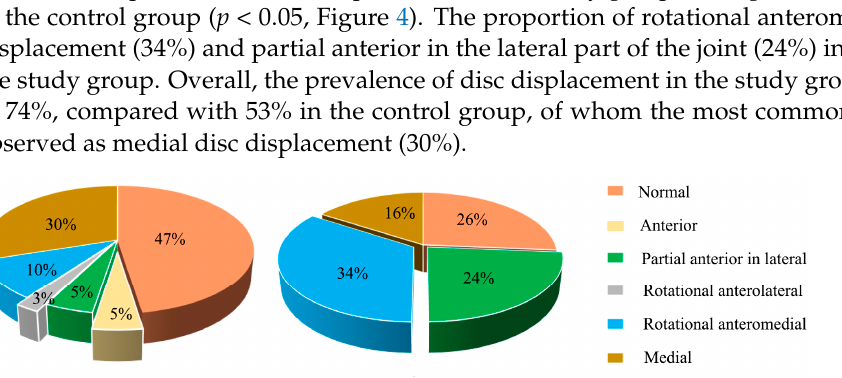
Figure 4. The proportion of disc displacement in the closed mouth position between the study group and the control group. The statistical results: x 2 = 16.338, p = 0.002.